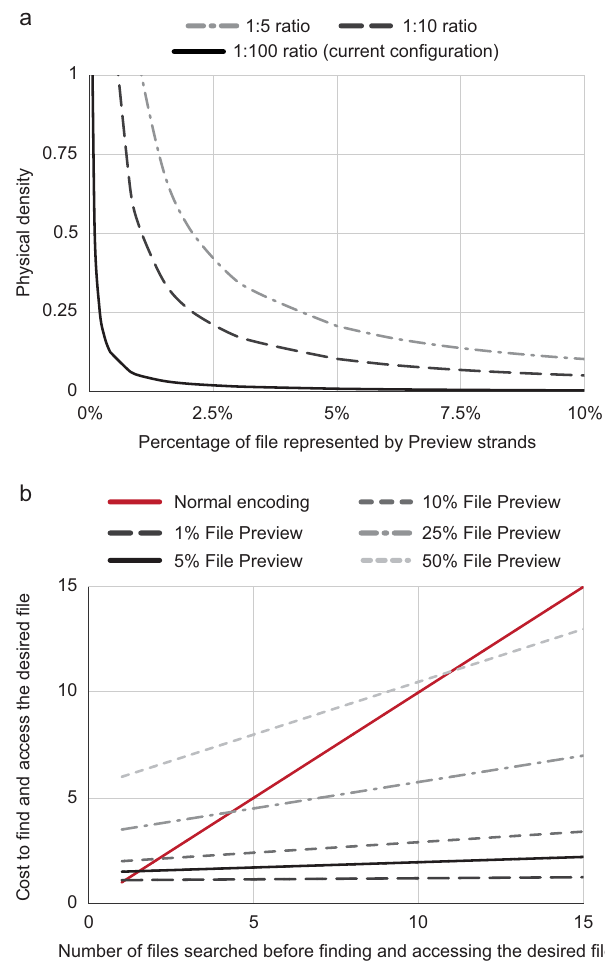
Fig. 4 File Preview can be implemented at similar densities while reducing sequencing costs. a Physical density to store a given fi le using Preview encoding normalized to the physical density of normal encoding. When holding the ratio of total preview strands to total full fi le strands constant at 100 (black line, current con fi guration), 10 (gray dashed line), or 5 copies (light-gray dashed-dot line), the physical density exponentially decreases as more of the fi le is stored in the Preview strands. b File Preview can cost-effectively fi nd a fi le in a library. Cost to fi nd a fi le is de fi ned as the normalized cost to fully sequence an entire fi le within a library, e.g., sequencing a 15- fi le database costs 15 on the y axis. File preview can be used to quickly and cheaply fi nd a fi le by sequencing a fewer total number of strands than is needed in a normally encoded library. Decreasing the percentage of each fi le stored in Preview strands further decreases the cost of fi nding a fi le. Source data are provided as a Source Data fi